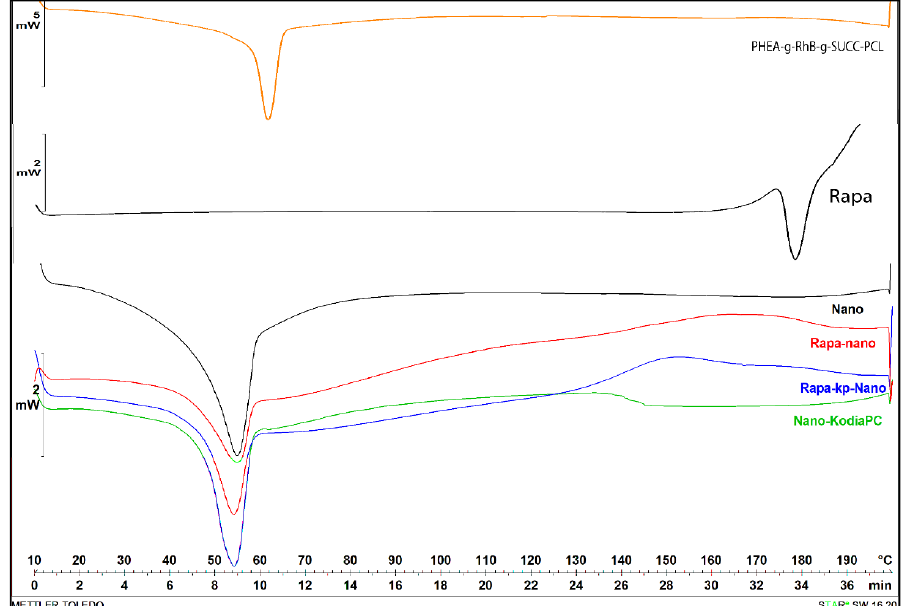
Figure 1. Differential scanning calorimetry (DSC) thermograms of first cooling cycle of Rapa, PHEA-g-RhB-g-SUCC-PCL graft copolymer, empty Nano (black curve), KP-Nano (green curve), Rapa-loaded Nano (red curve) and Rapa-loaded KP-Nano (blue curve).